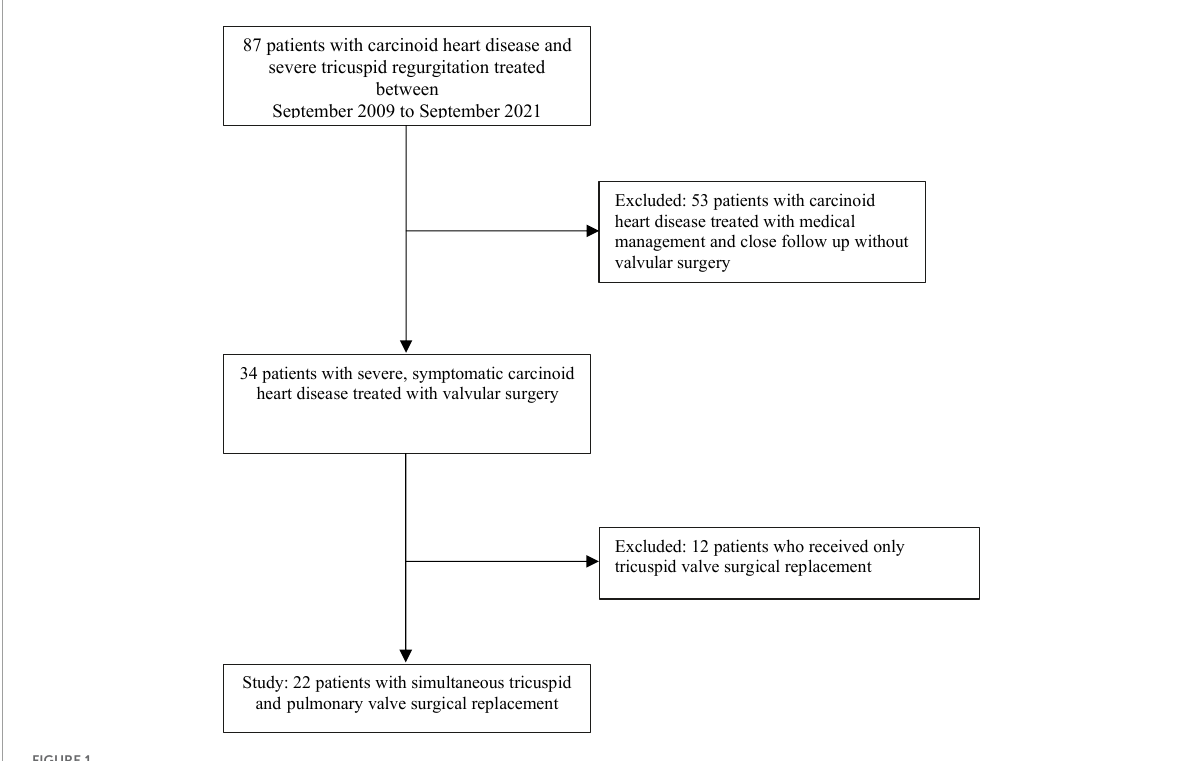
FIGURE1 Inclusion and exclusion criteria for the study.